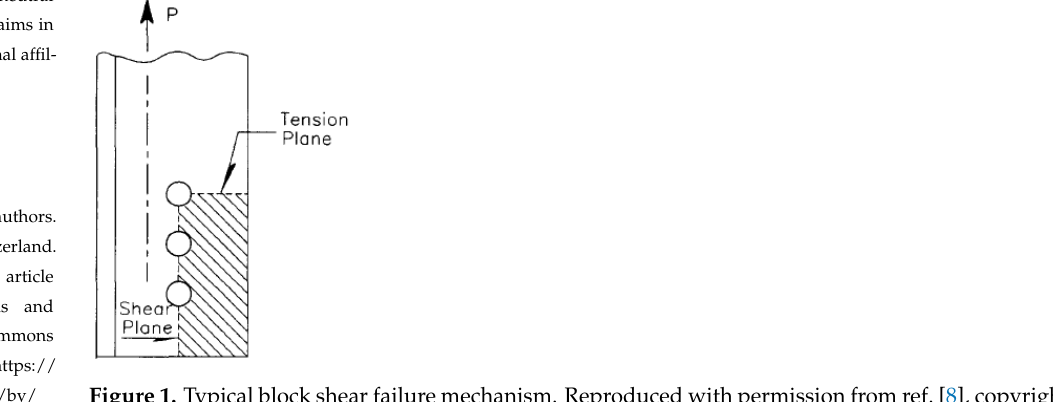
Figure 1. Typical block shear failure mechanism. Reproduced with permission from ref. [8], copyright (1995),